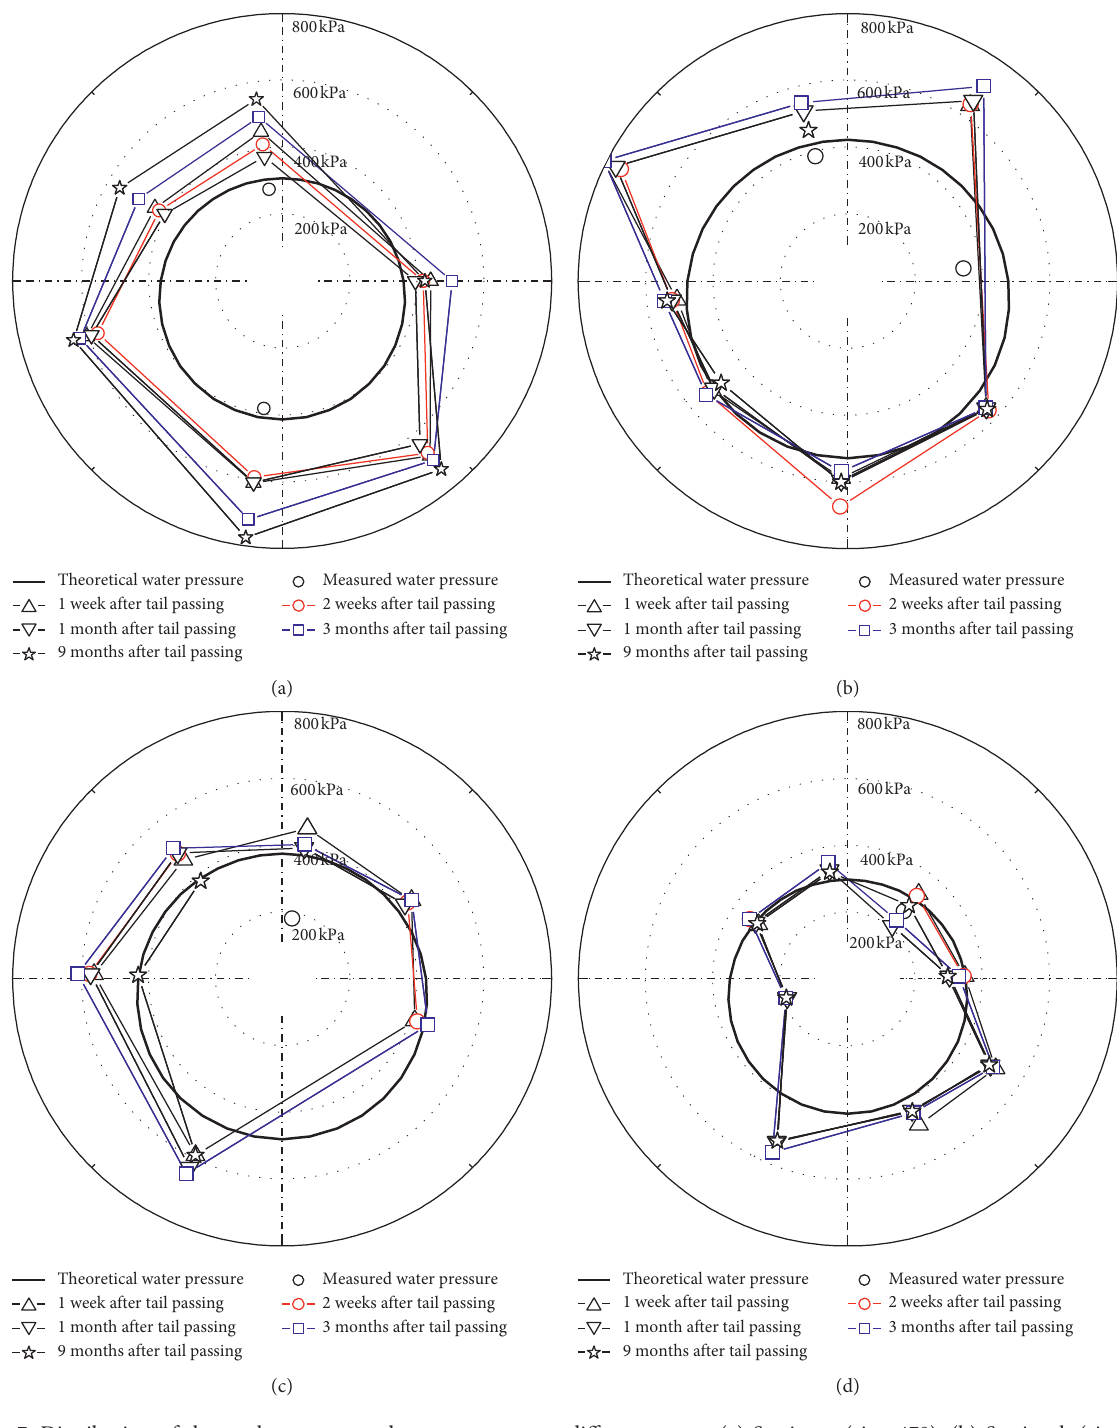
Figure 7: Distribution of the earth pressure and water pressure at different stages: (a) Section-a (ring 479), (b) Section-b (ring 1094), (c) Section-c (ring 1210), and (d) Section-d (ring